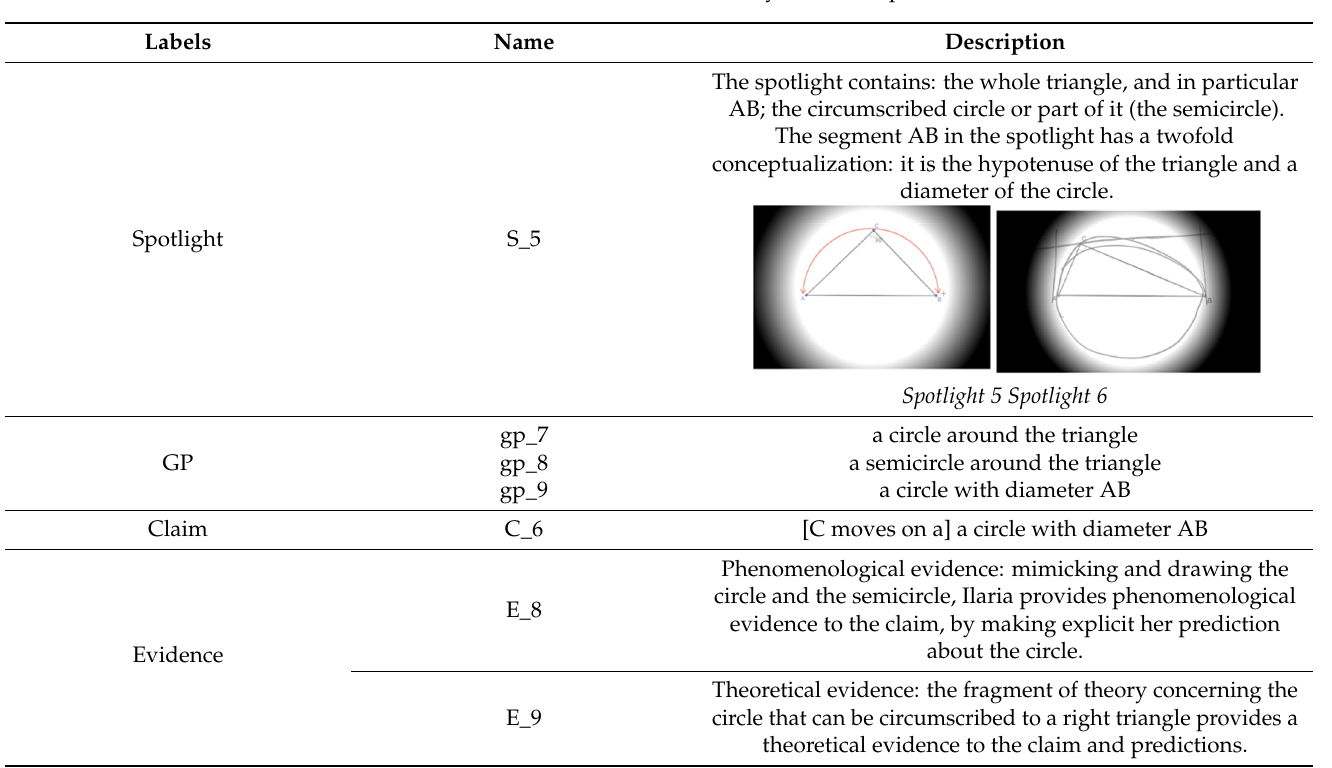
Table 12. Main elements from the analysis of Excerpt 6.